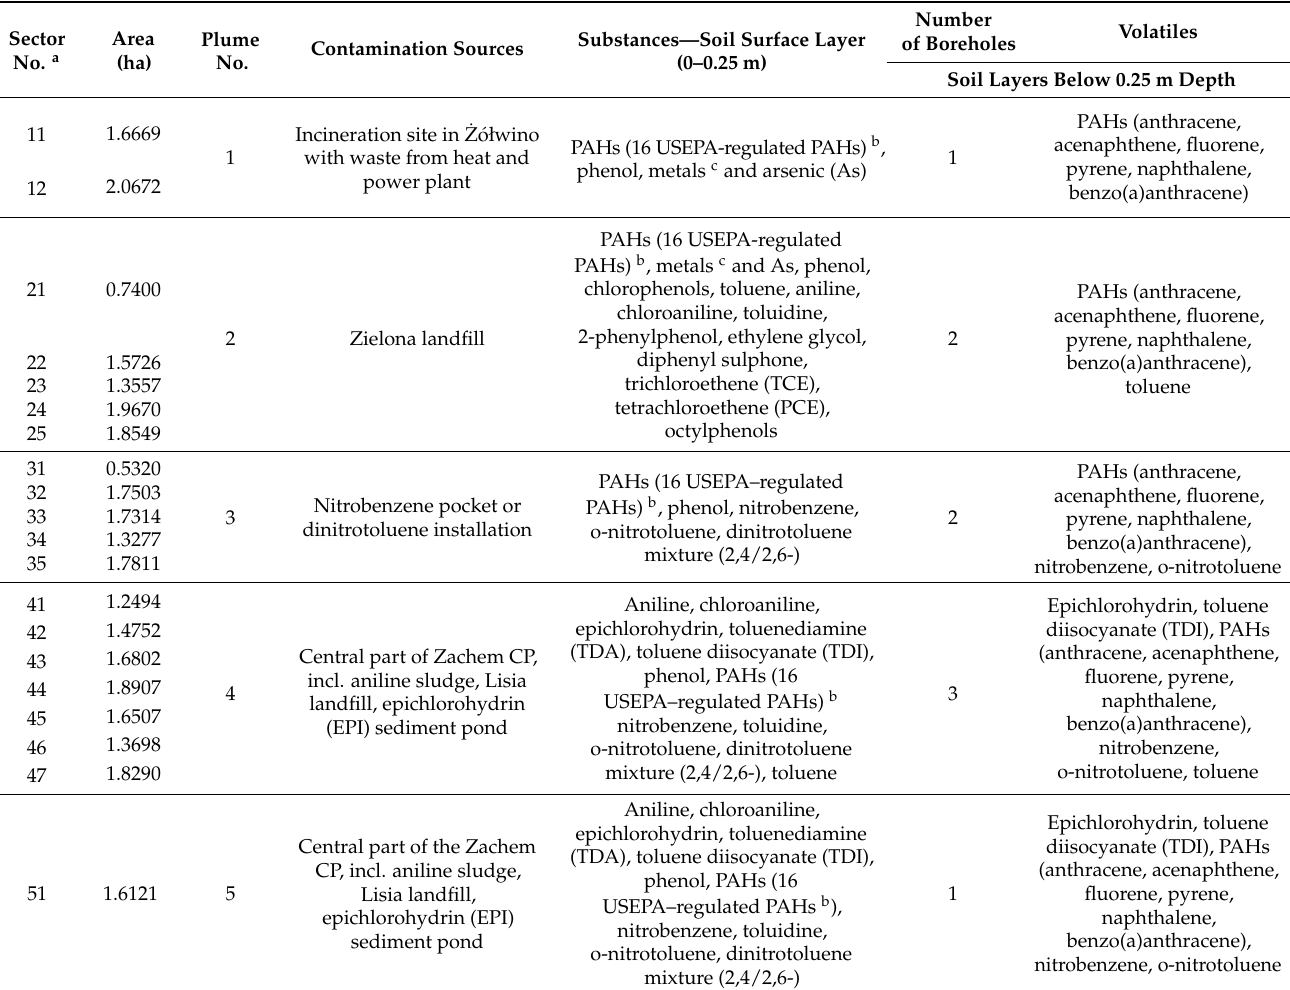
Table 2. Assignment of substances to contamination sources and plumes, broken down into sub- stances taken from the surface layer and deeper